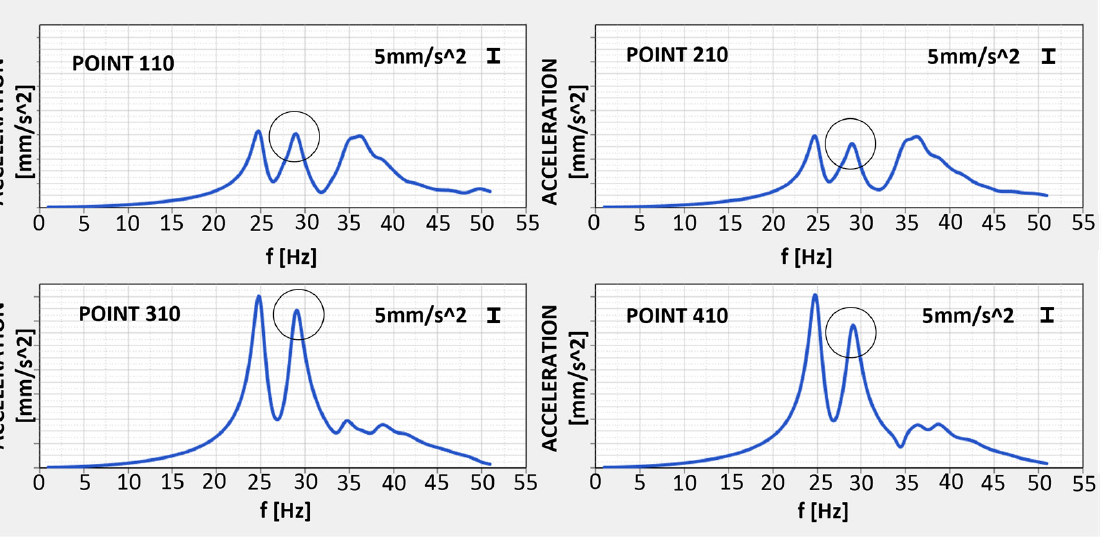
Figure 5. Accelerations on the four excited suspension points. In conclusion, the modal analysis was used in conjunction with the forced response analysis in order to identify the frequency of the first torsional mode for the BIW and TB